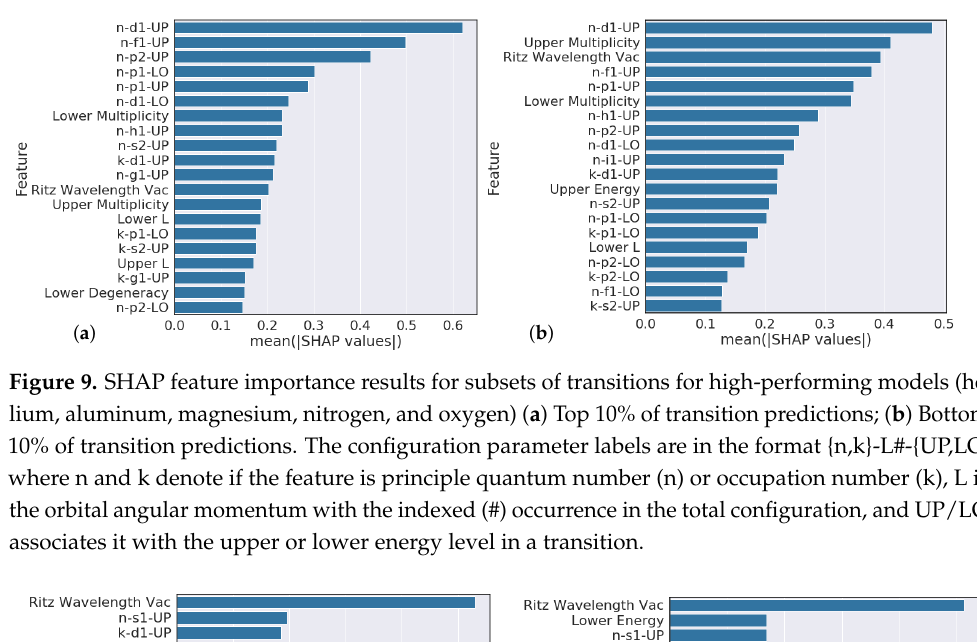
Figure 8. SHAP feature importance results. ( a ) high performing models (helium, aluminum, magne- sium, nitrogen, and oxygen); ( b ) low performing models (molybdenum, titanium, vanadium, iron, and chromium). The configuration parameter labels are in the format {n,k}-L#-{UP,LO}, where n and k denote if the feature is principle quantum number (n) or occupation number (k), L is the orbital angular momentum with the indexed (#) occurrence in the total configuration, and UP/LO associates it with the upper or lower energy level in a transition.